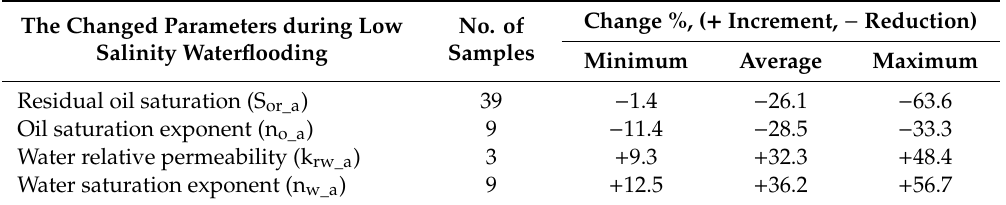
Table 2. Quantitative summary of the impact of the low salinity on the oil recovery through relative permeability parameters which was calculated from the published results of [20,21,23,25,26]. The Minimum and Maximum parameter values were computed from the references’ results while the average was obtained arithmetically.